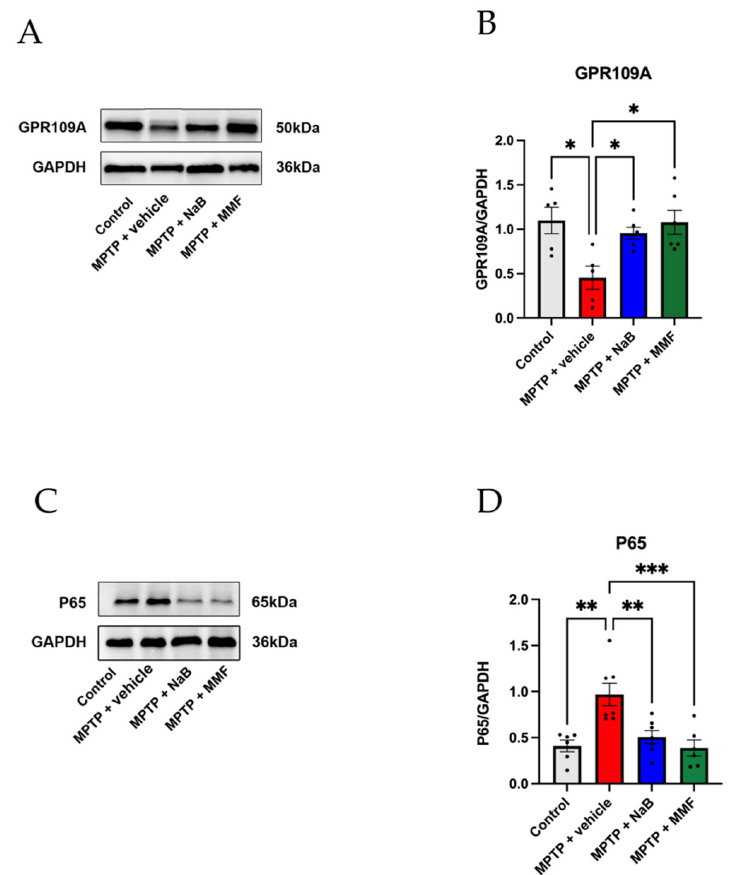
Figure 8. NaB and MMF inhibited the NF-κB pathway-mediated GPR109A to improve intestinal barrier damage in PD mice. ( A ) Representative immunoblot for colonic GPR109A. ( B ) NaB and MMF improve colonic GPR109A expression. (n = 5–6). ( C ) Representative immunoblot for colonic P65. ( D ) NaB and MMF inhibited colonic P65 expression. (n = 6–7). * p < 0.05, ** p < 0.01, *** p < 0.001 versus the MPTP + vehicle group.